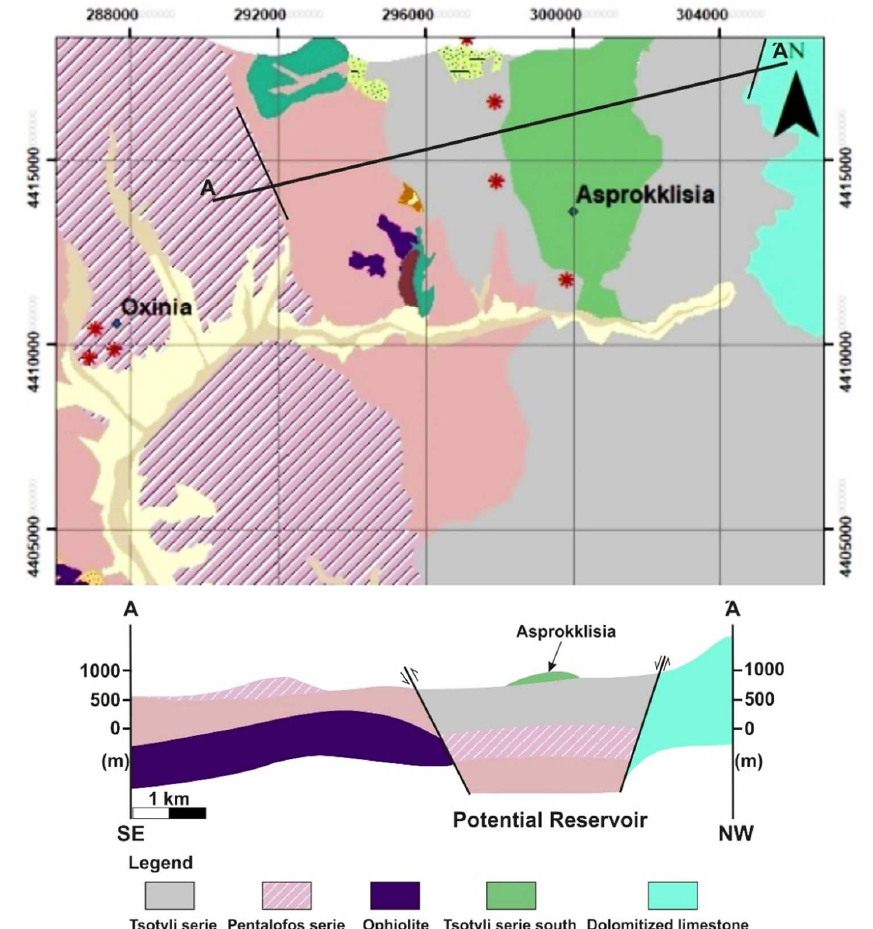
Figure 12. Geological map of the Southeast Mesohellenic Trough (northwest Greece) region and modified model for capacity after fieldwork mapping and experimental study (red star symbols in the map represent sampling areas).